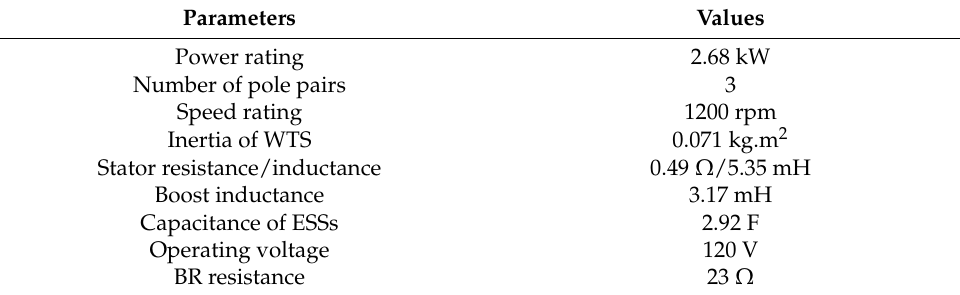
Table 4. Specifications of PMSG, ESSs, and BRs.